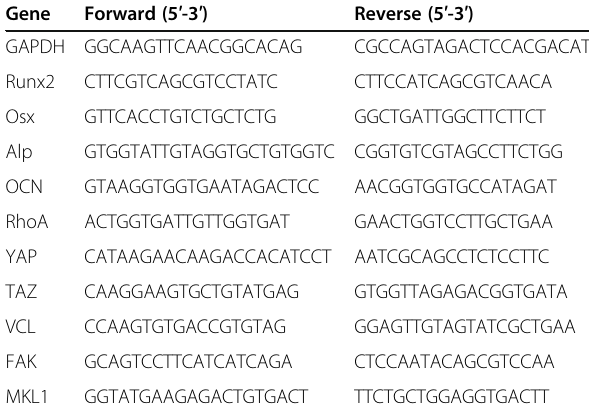
Table 1 Primers used in the qRT-PCR assay Gene Forward (5 ′ -3 ′